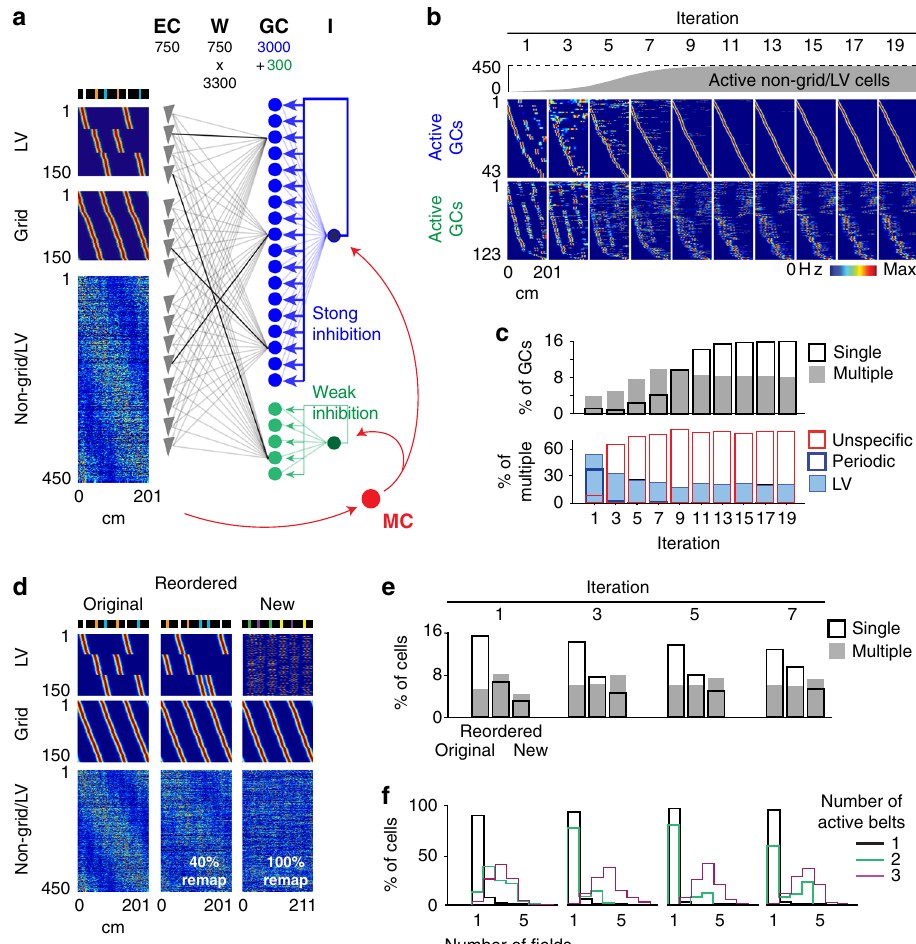
Fig. 8 Modeling multiple unspeci fi c fi elds and remapping experiments. a Model architecture. From the previous model design, a group of 450 spatially modulated non-grid/LV cells is added to the EC cell population, the number of Grid cells and LV cells is reduced to 150 to achieve the EC ratio of Grid cells and non-grid cells reported 23 , and a subgroup of 300 GCs under weak inhibition is added to the GC population. The fi ring fi elds of non-grid/LV cells were generated by the multiplication of noise and Gaussian signals to achieve lower spatial information 23 . The color scale is the same as that used in ( b ). b Transformation of spatial representations across iterations. Color-coded representation of rate maps for active GCs under high (blue) and low (green) inhibition, across iterations. In gray, the emergence of non-grid/LV cells across iterations. c Upper, proportion of GCs (irrespective of type) with a single fi eld (black) and multiple fi elds (gray), across iterations. Lower, proportion of LV, periodic and unspeci fi c GCs, among multiple- fi eld GCs, across iterations. Note the similarity with experimental trends (Fig. 3c). d The rate map of EC LV cells (upper), grid cells (middle) and non-grid/LV cells (lower) used to model the original (left), reordered (middle) and new (right) belts. To simulate the reordered belt, the fi ring fi elds of EC LV cells are moved to the new location of the landmarks, and 40% of non-grid/LV fi ring fi elds are randomly regenerated. To simulate the new belt, EC LV cells are randomly assigned to new landmarks, and all non-grid/LV fi ring fi elds are randomly regenerated. The color scale is the same as that used in ( b ). e Fraction of GCs with single (black) and multiple (gray) place fi elds in each belt, across iterations ( n = 3300 cells). Note the similarity with experimental trends (Fig. 5b). f The distribution of the number of fi elds per cell (using the belt with the largest number of fi elds) for the groups of GCs that are active in 1 (black), 2 (green), and 3 (purple) belts, across iterations. Note the similarity with experimental trends (Fig.